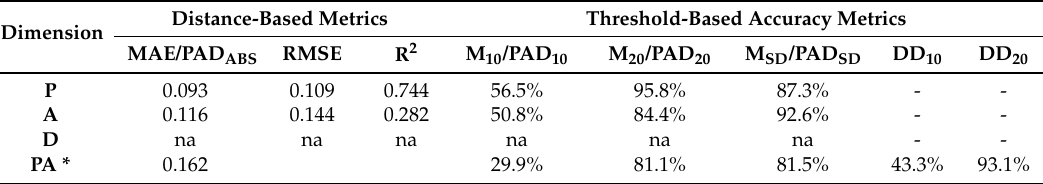
Table 10. Accuracy metrics for the mapping obtained from SYNE_ANEW applied on the NAWL-NAWL dataset (cross-set results).